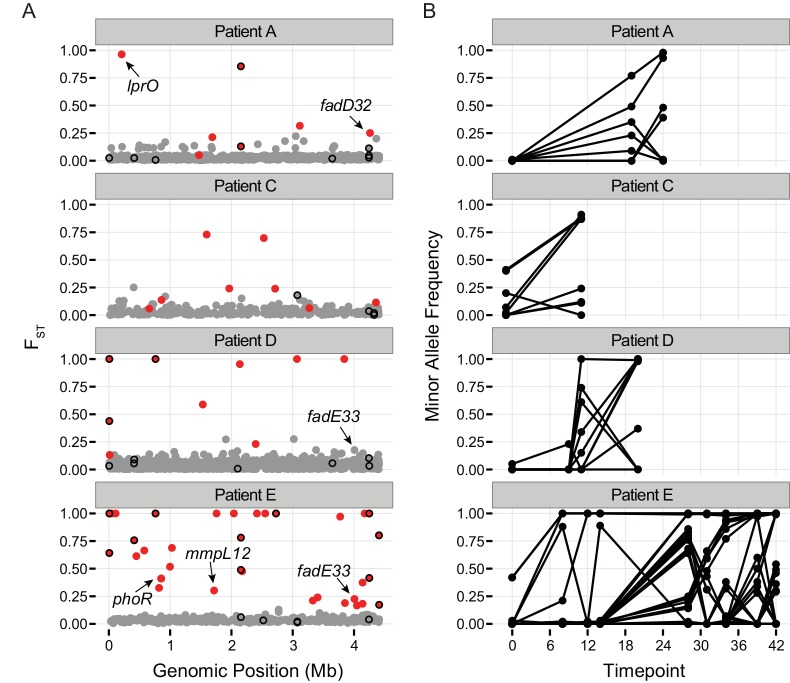
Population differentiation between samples.A.) Pairwise FST of polymorphic sites. Each patient sample was treated as a population and FST was calculated individually for each polymorphic site in a population. Calculations were performed on all polymorphic sites covered by at least 10 reads per sample for which the minor allele was supported by a minimum of 6 reads across all samples from the population (see Methods). Dots show the highest observed FST value for each single nucleotide polymorphism (SNP) across the H37Rv genome. Red color coding indicates allele frequencies changed significantly across the sampling interval (based on a Fisher’s exact test; q-value < 0.01). Genes implicated in drug resistance are outlined in black. Outliers of the FST distribution are likely to be under positive selection, or linked to a mutation under positive selection. B.) Allele frequencies over the course of treatment for SNPs with significant changes in allele frequency (red dots in A).